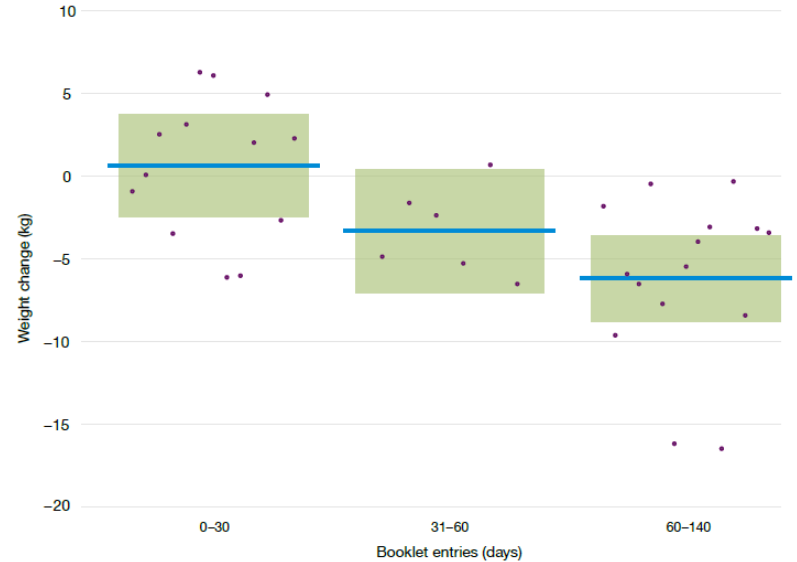
Figure 2. Comparison of weight loss (kg) of participants by the number of booklet entries, adjusted by sex. Horizontal lines represent the adjusted mean weight difference, the boxes represent the 95% confidence intervals around the mean values and dots represent individual weight changes.